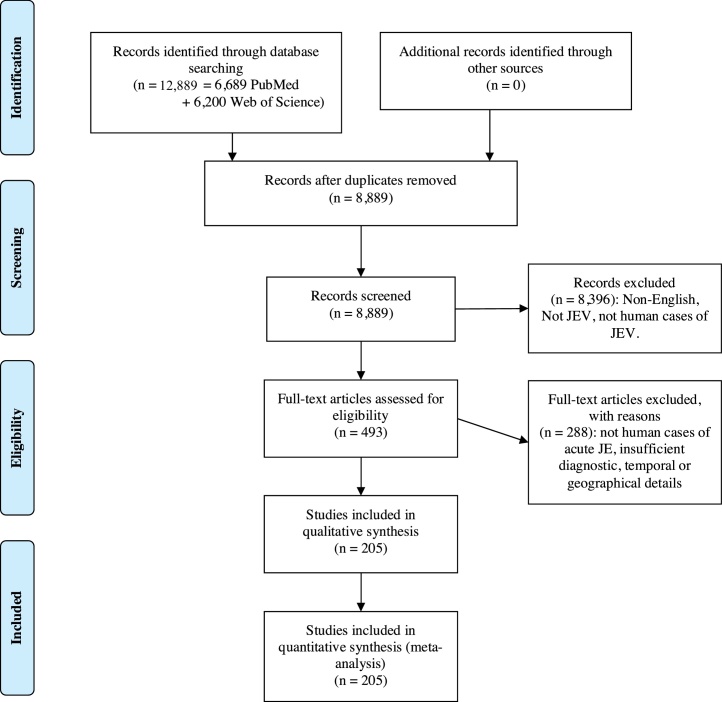
PRISMA flow diagram.